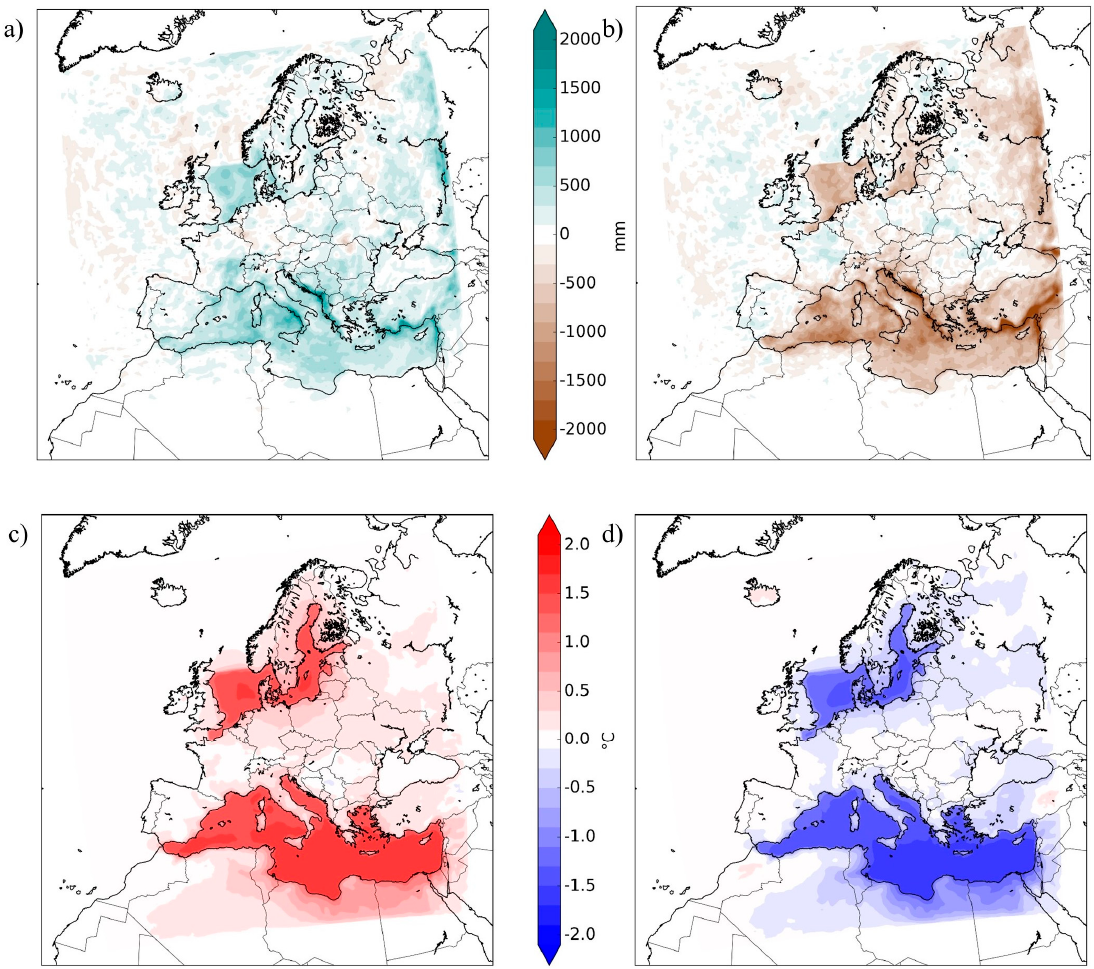
Figure 3. Difference between the SST_0 and the SST – 2 (left column, a , c ) or the SST + 2 (right column, b , d ) simulations. The first row ( a , b ) shows the difference of the precipitation sums during the whole time period (2000–2003) and the second row ( c , d ) shows the differences in 2 m temperature mean.